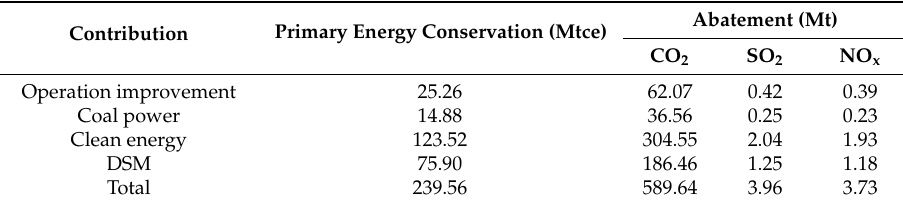
Table 11. Total potential of ECER